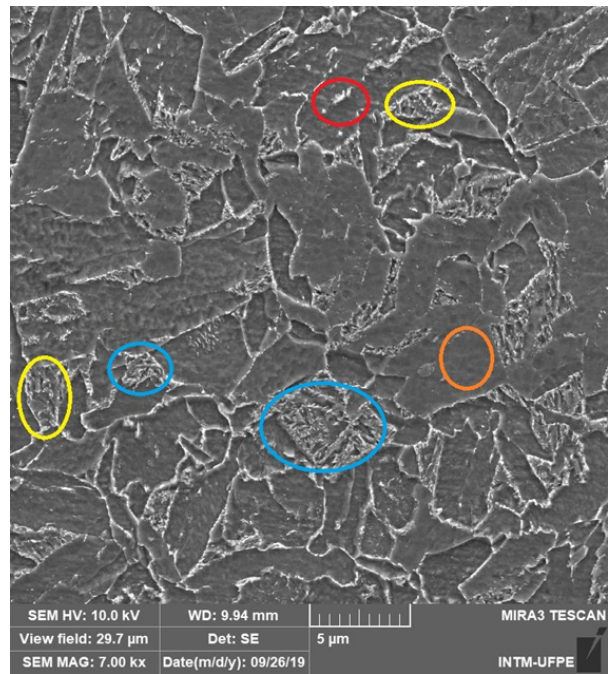
Figure 6. Microstructure of the material produced by the 480-15 sequence.